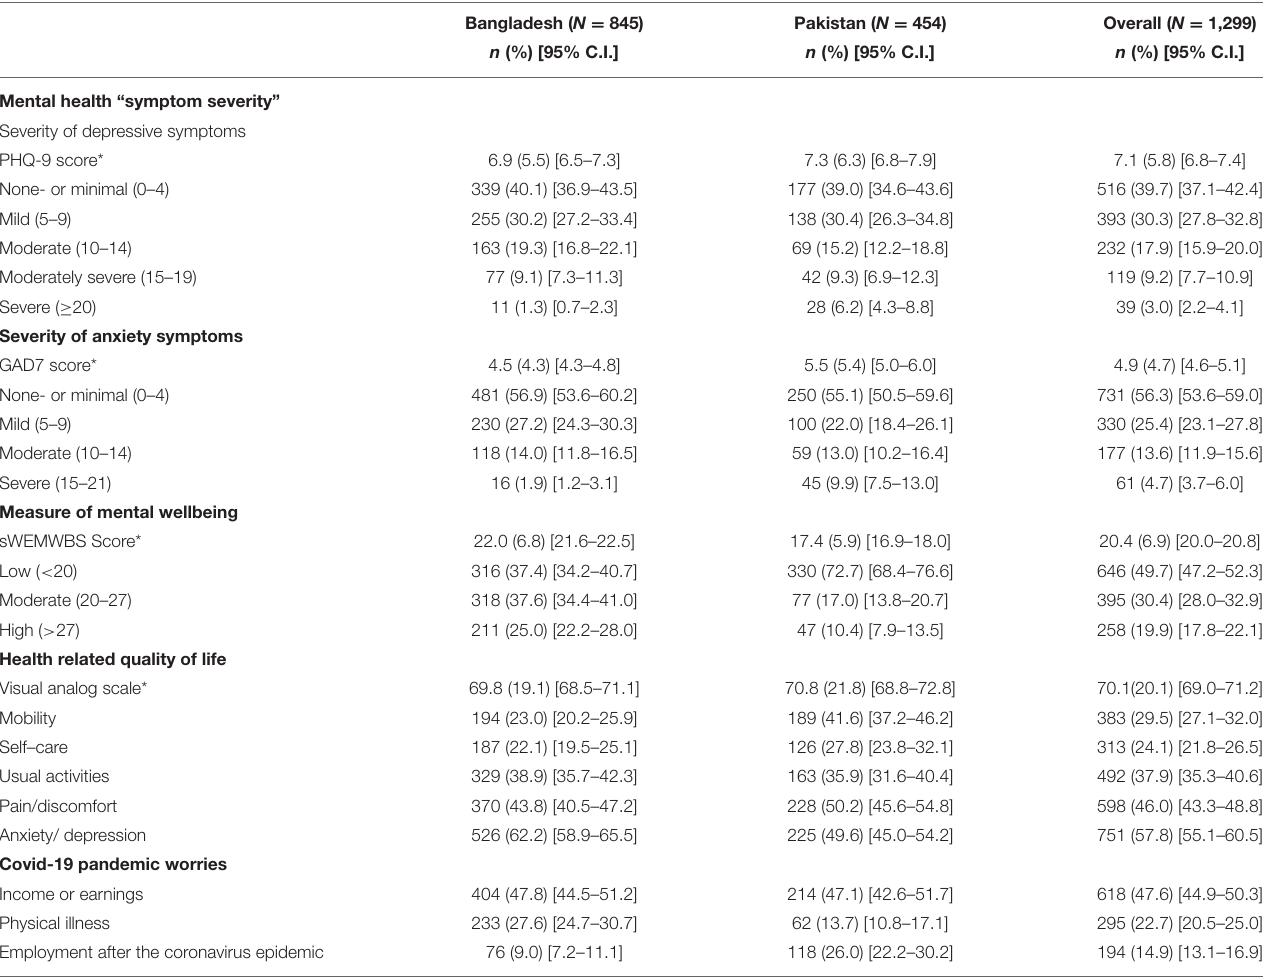
TABLE 2 | Mental health, wellbeing, health-related quality of life, and top worries of people with SMI in South Asia during the COVID-19 epidemic. Bangladesh ( N = 845) Pakistan ( N = 454) Overall ( N =